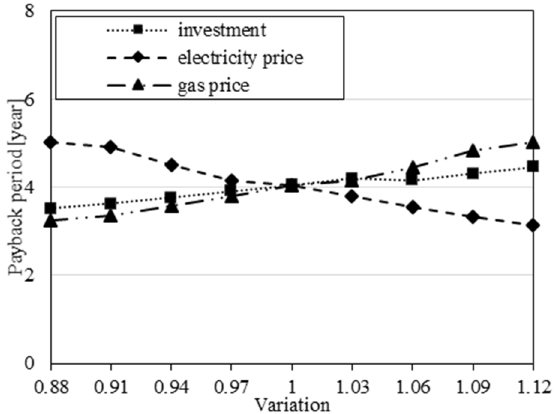
Figure 7. Sensitivity analysis of the project payback period by the standard economic method.